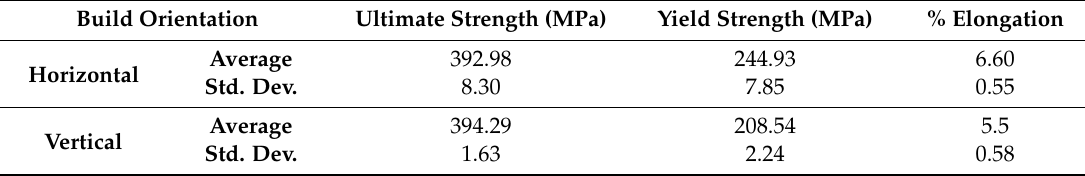
Table 1. Results from tensile testing campaign for Case Studies 1 and